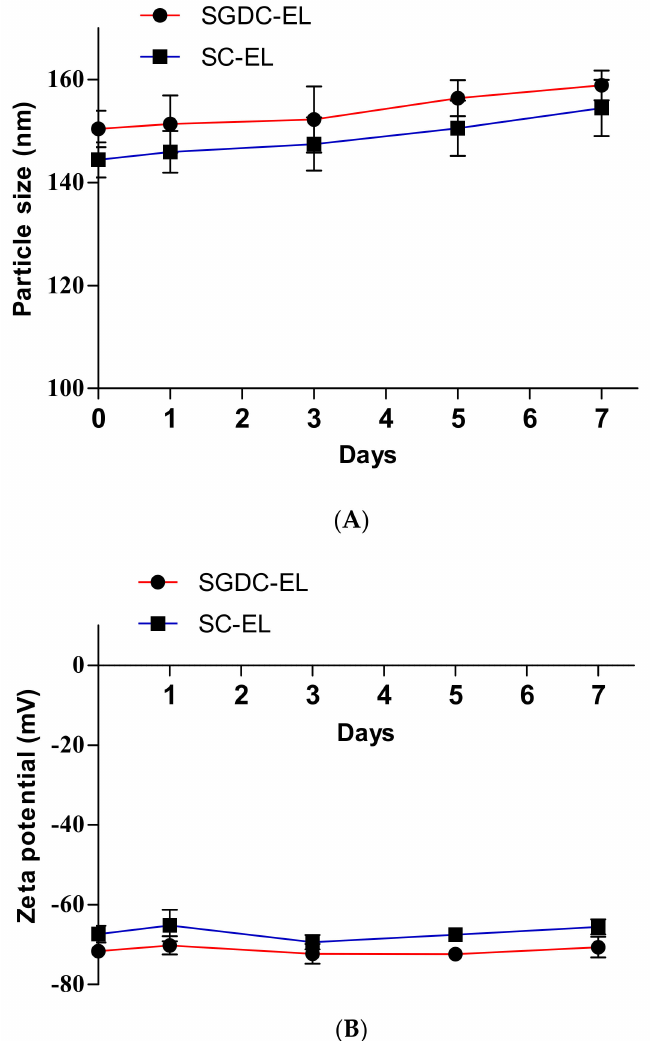
Figure 4. Physical stability of insulin-loaded elastic liposomes (SGDC-EL and SC-EL) at 4 ◦ C. Changes in the ( A ) particle sizes and ( B ) zeta potentials were observed at predetermined intervals over 7 days. Data are expressed as mean ± SD ( n =